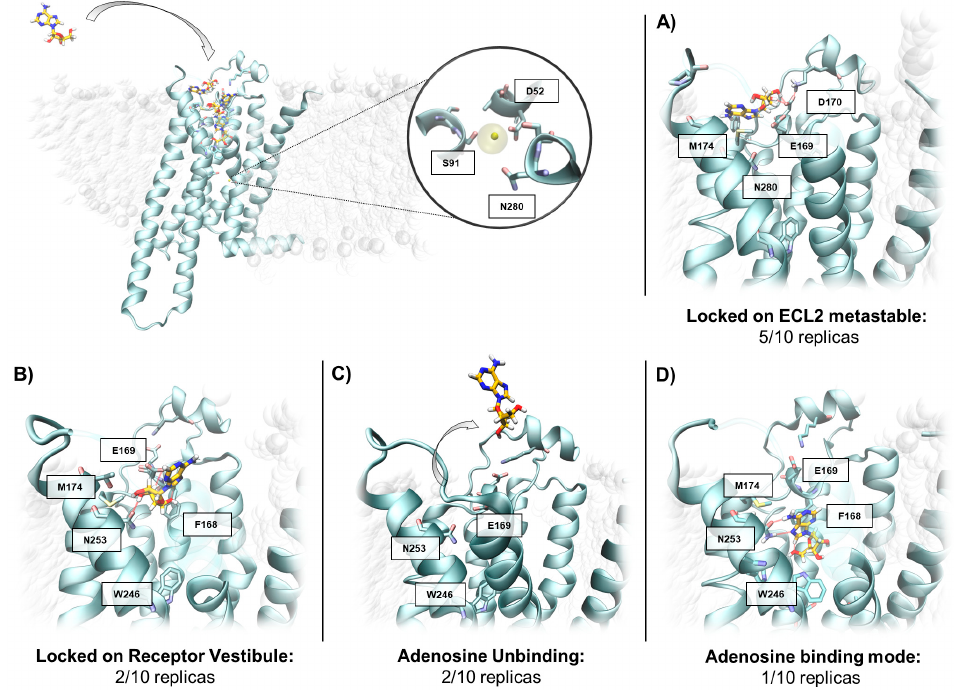
Figure 3. Conformations sampled by the adenosine while recognizing the A 2A AR in the inactive state. Top, the presence of the sodium ion in the allosteric binding site is highlighted. In panel A , a representative adenosine binding mode in the ECL2 metastable binding site is depicted. In panel B , one of the different conformations sampled by the adenosine in the receptor vestibule is reported. Panel C summarizes the number of ligand unbinding events collected, starting from the vestibule region. Panel D represents the only SuMD simulation (Replica 10i) that showed an adenosine crystallographic binding mode.